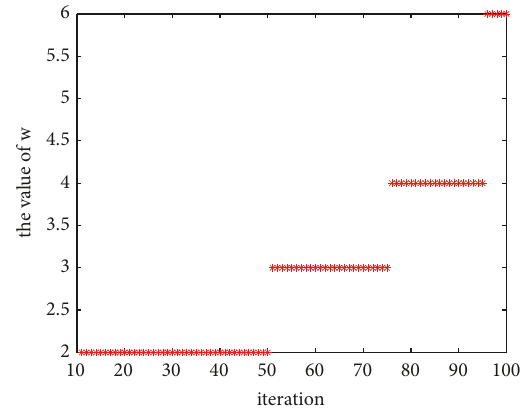
Figure 1: The value of the constant 𝑤